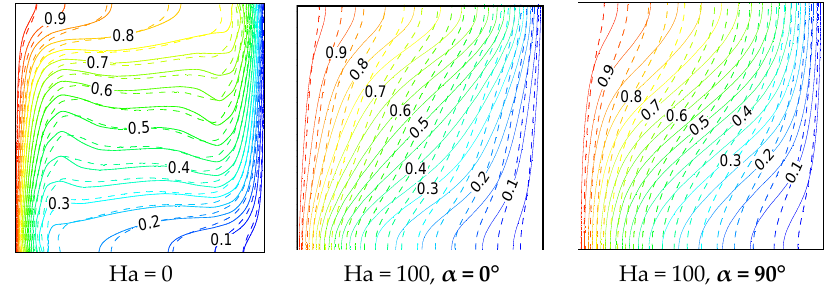
Figure 6. Isotherms in the mid- plane (solid φ = 0.05, dashed φ = 0) for Ra = 10 5.